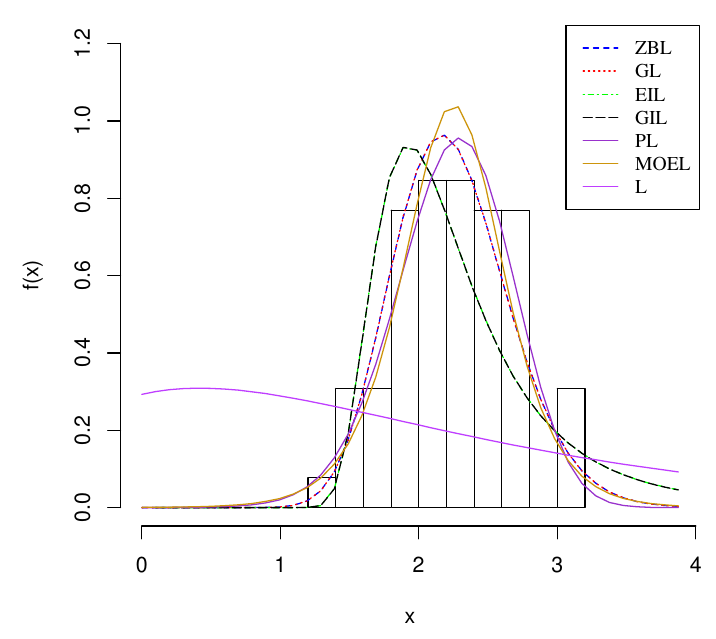
Figure 1 – The fitted densities of data of the failure stresses of single carbon